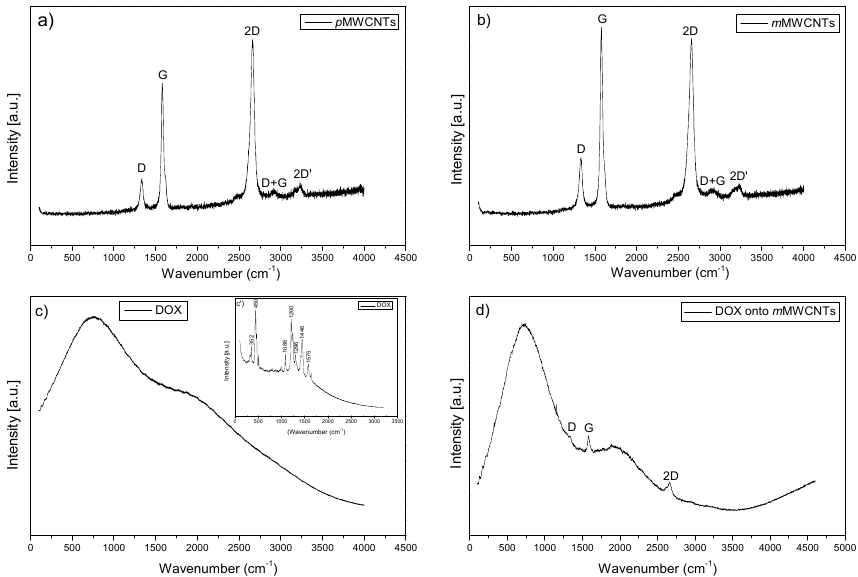
Figure 2. Raman spectroscopy results for p MWCNTs ( a ), m MWCNTs ( b ), DOX ( c , c’ ) and DOX onto m MWCNTs ( d ).